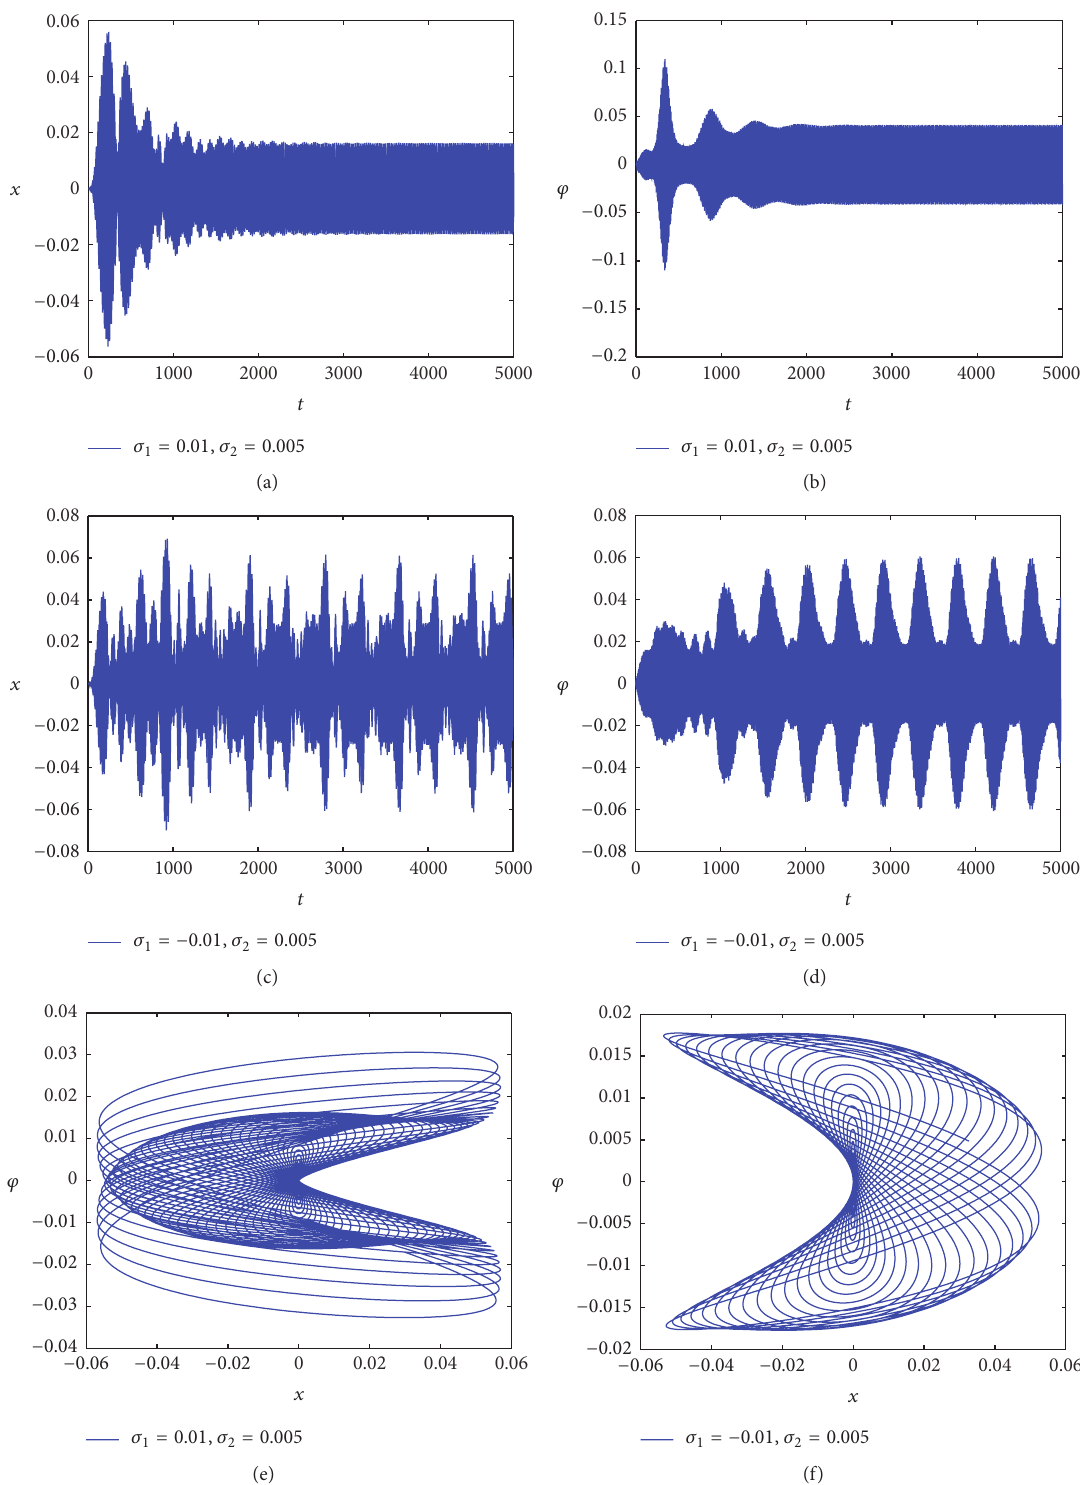
Figure 14: Plots (a), (b), (c), and (d) preform the portraits of time history, while plots (e) and (f) display the projections of the phase plane when 𝑎 = 𝑏 =